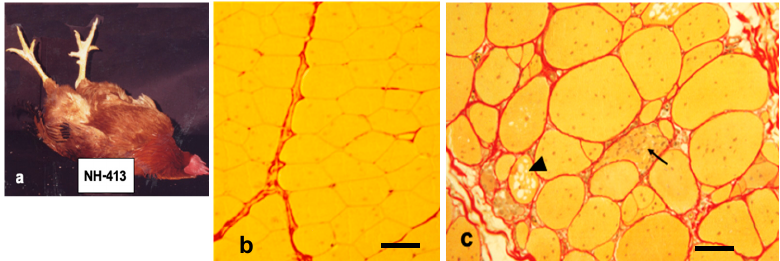
b Figure 1. Chickens with muscular dystrophy (line 413) cannot right themselves from the spine Figure 1. Chickens with muscular dystrophy (line 413) cannot right themselves from the spine Figure 1. Chickens with muscular dystrophy (line 413) cannot right themselves from the spine position when they placed on their back while normal birds stand up instantly from this position ( a ). Figure 1. Chickens with muscular dystrophy (line 413) cannot right themselves from the spine Figure 1. Chickens with muscular dystrophy (line 413) cannot right themselves from the spine Figure 1. Chickens with muscular dystrophy (line 413) cannot right themselves from the spine position when they placed on their back while normal birds stand up instantly from this position ( a ). position when they placed on their back while normal birds stand up instantly from this position ( a ). The pectoralis muscles from normal ( b ) and dystrophic ( c ) chickens at seven months are stained with position when they placed on their back while normal birds stand up instantly from this position ( a ). position when they placed on their back while normal birds stand up instantly from this position ( a ). position when they placed on their back while normal birds stand up instantly from this position ( a ). The pectoralis muscles from normal ( b ) and dystrophic ( c ) chickens at seven months are stained with The pectoralis muscles from normal ( b ) and dystrophic ( c ) chickens at seven months are stained with Sirius Red. Normal pectoral muscle fibers (line 412) have polygonal contour and yellow cytoplasm The pectoralis muscles from normal ( b ) and dystrophic ( c ) chickens at seven months are stained with The pectoralis muscles from normal ( b ) and dystrophic ( c ) chickens at seven months are stained with The pectoralis muscles from normal ( b ) and dystrophic ( c ) chickens at seven months are stained with Sirius Red. Normal pectoral muscle fibers (line 412) have polygonal contour and yellow cytoplasm Sirius Red. Normal pectoral muscle fibers (line 412) have polygonal contour and yellow cytoplasm Figure 1. Chickens with muscular dystrophy (line 413) cannot right themselves from the spine outlined basal lamina by bright red line. They are wrapped by reddish connective tissue. Dystrophic Figure 1. Chickens with muscular dystrophy (line 413) cannot right themselves from the spine Figure 1. Chickens with muscular dystrophy (line 413) cannot right themselves from the spine position Sirius Red. Normal pectoral muscle fibers (line 412) have polygonal contour and yellow cytoplasm Sirius Red. Normal pectoral muscle fibers (line 412) have polygonal contour and yellow cytoplasm Sirius Red. Normal pectoral muscle fibers (line 412) have polygonal contour and yellow cytoplasm outlined basal lamina by bright red line. They are wrapped by reddish connective tissue. Dystrophic outlined basal lamina by bright red line. They are wrapped by reddish connective tissue. Dystrophic position when they placed on their back while normal birds stand up instantly from this position ( a ). pectoralis muscles are earliest and most severely affected, which are characterized by a marked position when they placed on their back while normal birds stand up instantly from this position ( a ). when they placed on their back while normal birds stand up instantly from this position ( a ). The pectoralis The pectoralis muscles from normal ( b ) and dystrophic ( c ) chickens at seven months are stained with outlined basal lamina by bright red line. They are wrapped by reddish connective tissue. Dystrophic outlined basal lamina by bright red line. They are wrapped by reddish connective tissue. Dystrophic outlined basal lamina by bright red line. They are wrapped by reddish connective tissue. Dystrophic pectoralis muscles are earliest and most severely affected, which are characterized by a marked pectoralis muscles are earliest and most severely affected, which are characterized by a marked The pectoralis muscles from normal ( b ) and dystrophic ( c ) chickens at seven months are stained with variation in size with a proliferation of intracellular nuclei, necrotic phagocytosis (arrow), muscles from normal ( b ) and dystrophic ( c ) chickens at seven months are stained with Sirius Red. Normal Sirius Red. Normal pectoral muscle fibers (line 412) have polygonal contour and yellow cytoplasm pectoralis muscles are earliest and most severely affected, which are characterized by a marked pectoralis muscles are earliest and most severely affected, which are characterized by a marked pectoralis muscles are earliest and most severely affected, which are characterized by a marked variation in size with a proliferation of intracellular nuclei, necrotic phagocytosis (arrow), variation in size with a proliferation of intracellular nuclei, necrotic phagocytosis (arrow), Sirius Red. Normal pectoral muscle fibers (line 412) have polygonal contour and yellow cytoplasm multivesicular fibers (arrow head) and fibrosis with lipid droplets. Note that dystrophic fibers lead to pectoral muscle fibers (line 412) have polygonal contour and yellow cytoplasm outlined basal lamina by outlined basal lamina by bright red line. They are wrapped by reddish connective tissue. Dystrophic variation in size with a proliferation of intracellular nuclei, necrotic phagocytosis (arrow), variation in size with a proliferation of intracellular nuclei, necrotic phagocytosis (arrow), variation in size with a proliferation of intracellular nuclei, necrotic phagocytosis (arrow), multivesicular fibers (arrow head) and fibrosis with lipid droplets. Note that dystrophic fibers lead to multivesicular fibers (arrow head) and fibrosis with lipid droplets. Note that dystrophic fibers lead to outlined basal lamina by bright red line. They are wrapped by reddish connective tissue. Dystrophic develop thicker endomysium layer compared to age matched wild-type ones. Bars in (b) and (c) pectoralis muscles are earliest and most severely affected, which are characterized by a marked bright red line. They are wrapped by reddish connective tissue. Dystrophic pectoralis muscles are earliest multivesicular fibers (arrow head) and fibrosis with lipid droplets. Note that dystrophic fibers lead to multivesicular fibers (arrow head) and fibrosis with lipid droplets. Note that dystrophic fibers lead to multivesicular fibers (arrow head) and fibrosis with lipid droplets. Note that dystrophic fibers lead to develop thicker endomysium layer compared to age matched wild-type ones. Bars in (b) and (c) develop thicker endomysium layer compared to age matched wild-type ones. Bars in (b) and (c) pectoralis muscles are earliest and most severely affected, which are characterized by a marked indicate 80 and 100 μ m, respectively. variation in size with a proliferation of intracellular nuclei, necrotic phagocytosis (arrow), and most severely affected, which are characterized by a marked variation in size with a proliferation of multivesicular fibers (arrow head) and fibrosis with lipid droplets. Note that dystrophic fibers lead to develop thicker endomysium layer compared to age matched wild-type ones. Bars in (b) and (c) develop thicker endomysium layer compared to age matched wild-type ones. Bars in (b) and (c) develop thicker endomysium layer compared to age matched wild-type ones. Bars in (b) and (c) indicate 80 and 100 μ m, respectively. indicate 80 and 100 μ m, respectively. variation in size with a proliferation of intracellular nuclei, necrotic phagocytosis (arrow), intracellular nuclei, necrotic phagocytosis (arrow), multivesicular fibers (arrow head) and fibrosis with develop thicker endomysium layer compared to age matched wild-type ones. Bars in (b) and (c) indicate 80 and 100 μ m, respectively. indicate 80 and 100 μ m, respectively. indicate 80 and 100 μ m, respectively. multivesicular fibers (arrow head) and fibrosis with lipid droplets. Note that dystrophic fibers lead to lipid droplets. Note that dystrophic fibers lead to develop thicker endomysium layer compared to age indicate 80 and 100 μ m, respectively. develop thicker endomysium layer compared to age matched wild-type ones. Bars in (b) and (c) matched wild-type ones. Bars in (b) and (c) indicate 80 and 100 µ m, respectively. indicate 80 and 100 μ m, respectively.